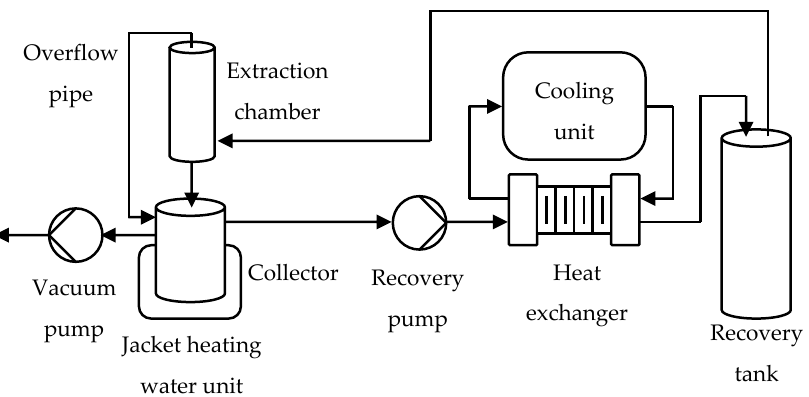
Figure 8. Schematic diagram of HFC-134a extraction on Jasminum sambac .